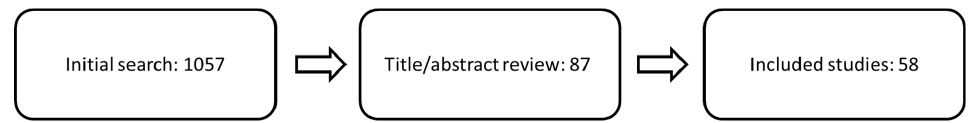
Figure 1. Literature review carried out in February 2022, which included the PubMed and Embase databases. Searches included terms relating to NAD+ and its precursors (e.g., NADH, NAD+, nicotinamide, NAM, nicotinamide mononucleotide, NMN, niacin, and nicotinic acid) and terms relating to cognition (e.g., cognitive, intelligence, dementia, and Alzheimer’s cognition), which were joined using Boolean operators. ‘Snowballing’ of the reference lists of the included studies was used to identify further relevant publications.